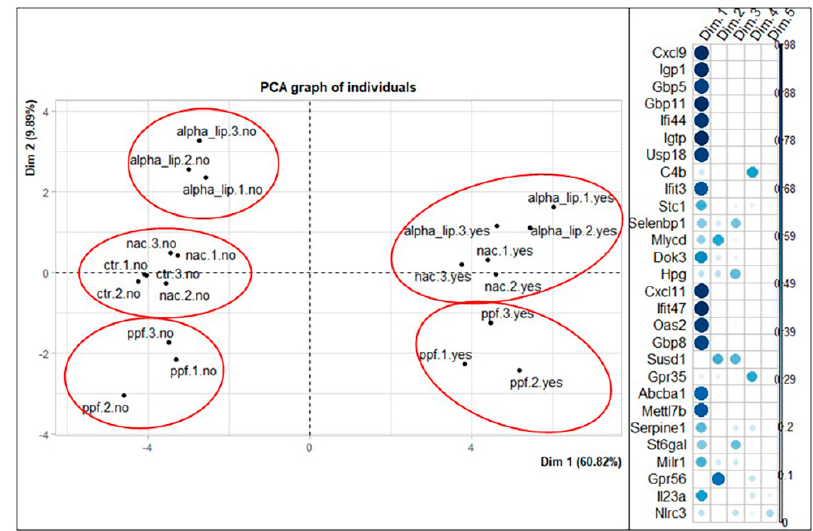
Figure 7. Representation of the distribution of samples in the new coordinate system obtained through the PCA technique for HT22 cell line. Correlation plot shows how much a gene contributes to each dimension of the new coordinate system. alpha_lip: α -lipoic acid; nac: N-acetyl-cystein; ppf: propentofylline; yes/no: presence/absence of active principle treatment; 1/2/3: replicates.